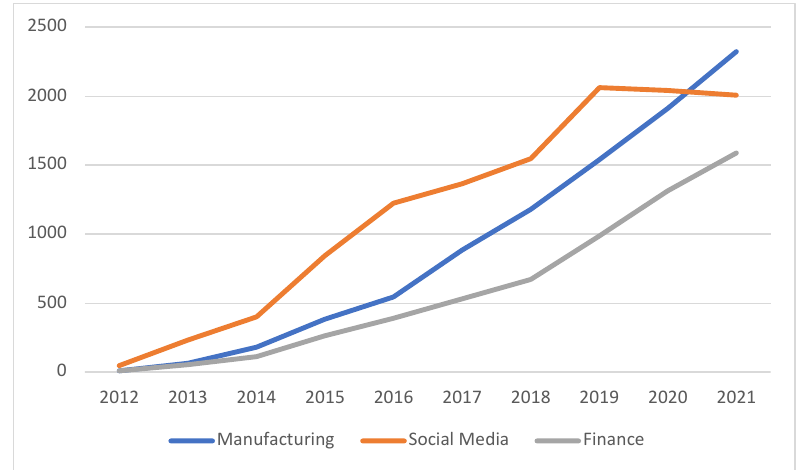
Figure 2. The number of research publications per year for the Big Data application areas manufac- turing, social media and finance.